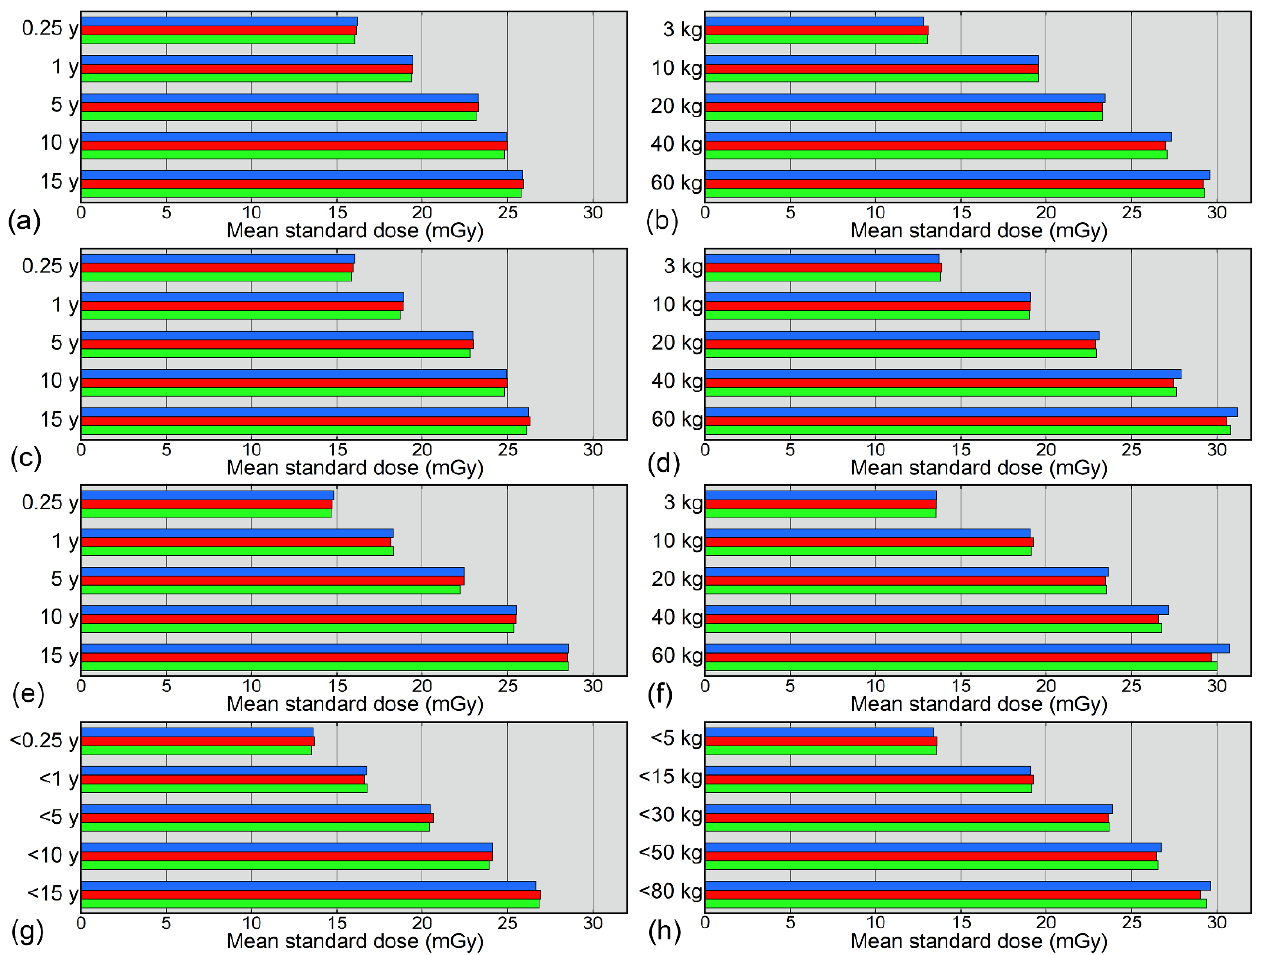
Figure 4. Mean standard doses estimated based on age ( a , c , e , g ) or weight ( b , d , f , h ). Standard doses